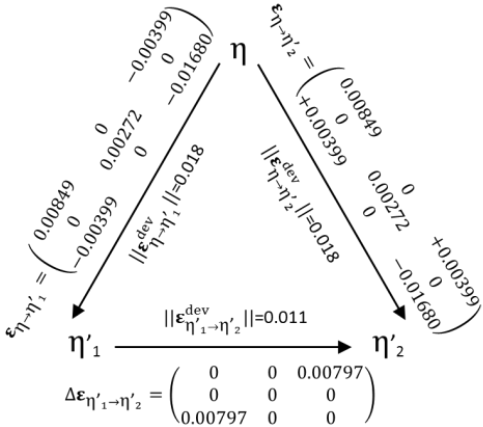
Figure A1. Symmetric strains relating the structures of the orthorhombic η phase and the two principal domain states of the monoclinic η′ phase as calculated on the basis of the lattice parameters given in Table 2. The strains are given in the directions of the arrows. The reverse arrow directions imply the corresponding negative strains.